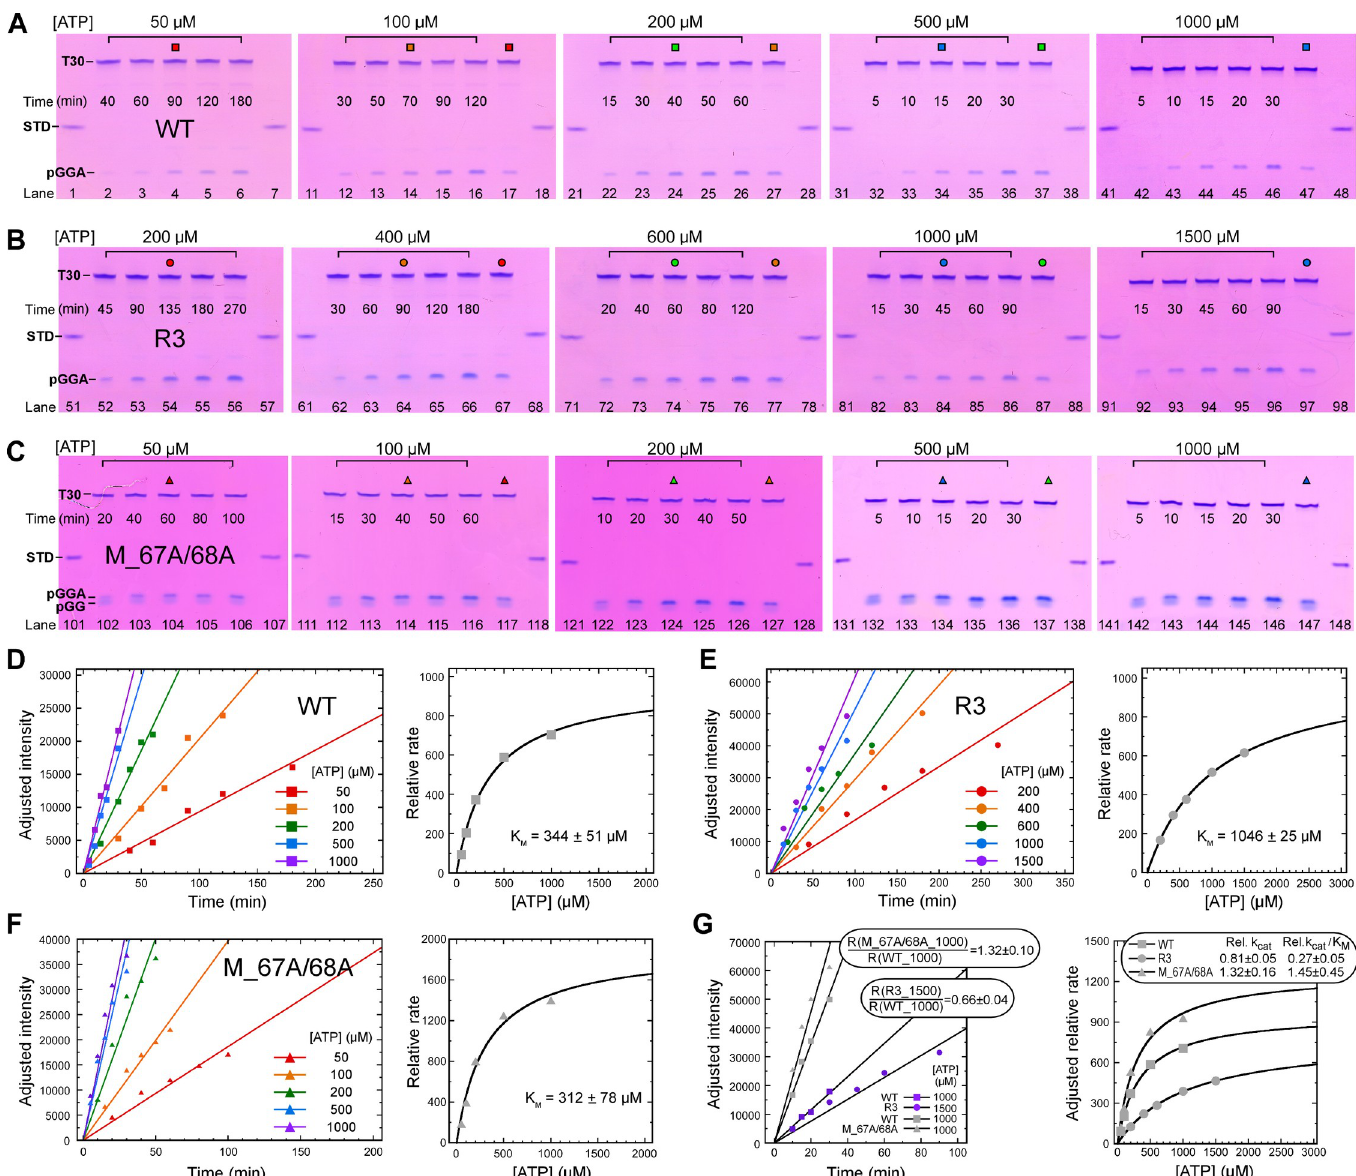
Fig 7. Characterization of the initiation kinetics on the WT DENV2 NS5 and representative NS5 mutants. A-C) The P3 (pGGA) formation under different ATP concentrations by the WT (A), R3 (B), and M_67A/68A (C) constructs. The color-coded icons above the lanes indicate samples from the same reaction mixture that were used to correlate intensity in different gels (see Materials and Methods). The STD samples were used as a reference and NTP concentration range was adjusted for each NS5 construct, both for ensuring that all P3 band intensities were within the linear range of the staining method used. D-F) The relative reaction rates (left) and K (right) analyses for the WT (D), R3 (E), and M_67A/68A (F) constructs. Left: The adjusted intensity of the 3-mer products as a function of time for WT, R3, and M_67A/ 68A with five ATP concentrations. (G) An analysis of the relative specificity constants of the R3 and M_67A/68A mutants to the WT. Single-gel based reaction rate correlation analysis (left) for the R3-WT (purple points) and M_67A/68A-WT pairs to correlate three Michaelis-Menten curves for determination of the relative specificity constants (right).